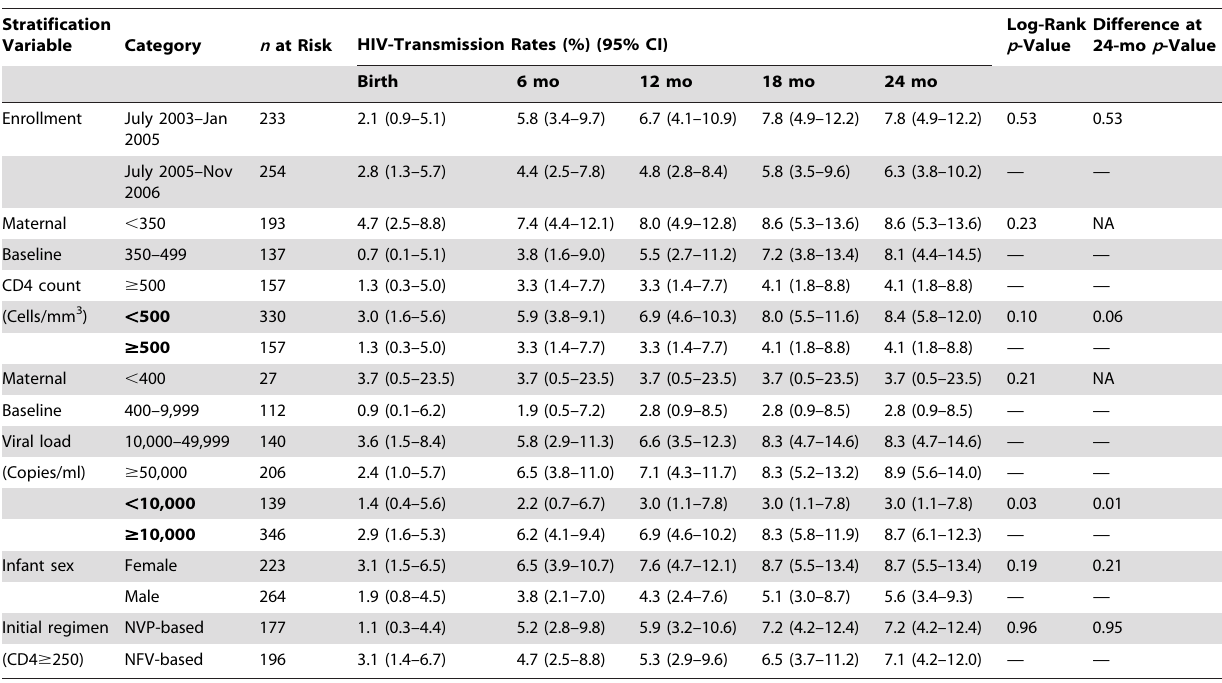
Table 4. Stratified Kaplan-Meier estimates of HIV-transmission rates among live-born singletons and first-born infants. Stratification Variable